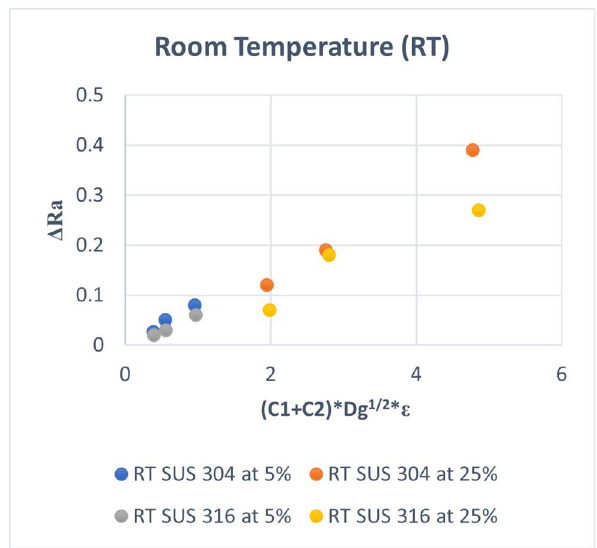
Figure 12. ∆ Ra versus (C1 + C2) × g 1/2 × E at